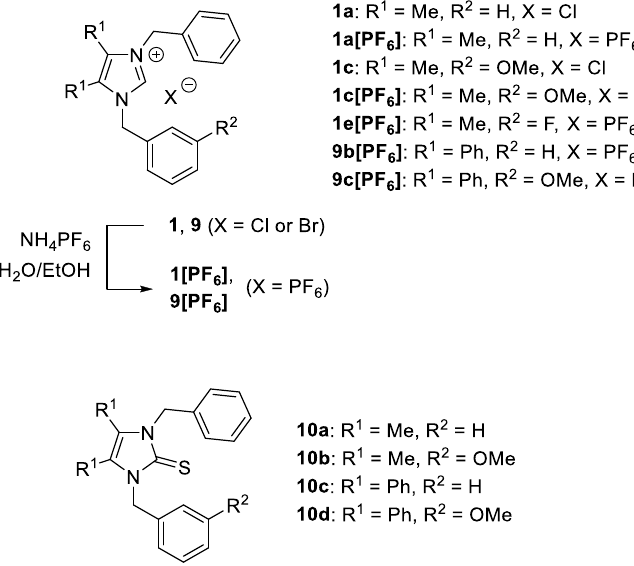
Figure 3. Ion exchange in selected lepidiline-derived imidazolium salts of types 1 and 9 and the structures of imidazole-2-thiones 10 used in this study.